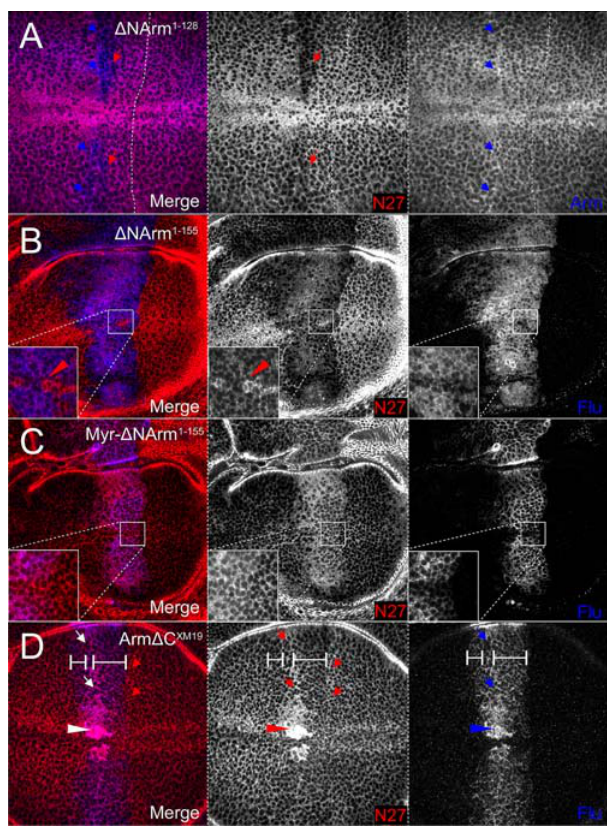
Figure 9. Strength of association of Armadillo with the basolateral membrane is dependent upon both the N- and C- termini. (A) UAS D NArm 1–128 is targeted normally to the membrane, including the anterior ‘‘stripe’’ (blue arrows). Endogenous Armadillo is excluded (red arrows), but only in the domain of highest dppGAL4 expression. (B) The D NArm 1–155 construct is similar to Arm S10 but more soluble (red channel), excluding endogenous Armadillo from the membrane at the edges of the dppGAL4 expression domain. However, few puncta are observed (red, inset). (C) The membrane-tethered Myr- D NArm 1–155 is not freely diffusible (blue channel, inset) and drives endogenous Armadillo into the nucleus, but does not appear to alter its ability to associate with the membrane (red inset). (D) Arm D C XM19 , though diffusely associated with the membrane (blue), replaces endogenous Armadillo in the entire domain of expression (red channel, white scale bars), but is targeted to the anterior stripe like the endogenous form under wild type conditions (small arrows, all channels). Arm D C XM19 is also weakly nuclear in Wg-receiving cells (arrowheads, all channels). Although the N27A1 antibody recognises both the construct and endogenous Armadillo, the endogenous protein also appears to localise more strongly in the nuclei (red